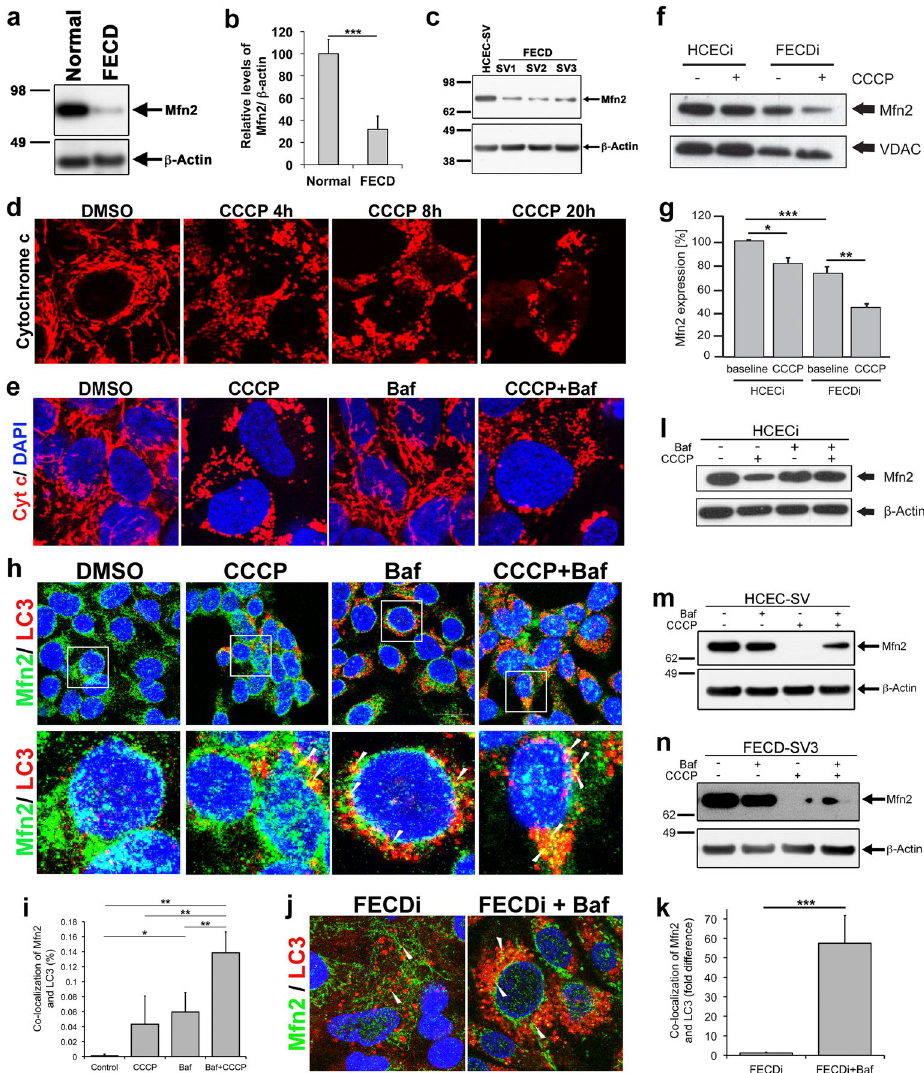
Figure 4. Mitophagy drives loss of mitochondrial fusion protein Mfn2 in FECD. ( a ) Representative western blot of Mfn2 shows reduced expression in an FECD specimen compared to normal donor. ( b ) Quantification of western blot of Mfn2 (average + SEM) normalized with β -actin from normal donors (n = 10) and FECD ex vivo specimens (n = 10) showed a loss of Mfn2 in FECD ( P = 0.0005, Student’s t -test). ( c ) Western blot of SV40 immortalized normal (HCEC-SV) and FECD cell lines (FECD-SV1, -SV2, and -SV3) show reduced Mfn2 levels that corroborated with human specimens. ( d ) Time course of mitochondrial fragmentation observed with the immunolocalization of cytochrome c in normal corneal endothelial cell lines treated with 20 μ M CCCP. ( e ) CCCP- induced mitochondrial fragmentation is unaltered with autophagosome inhibitor bafilomycin (10 nM) (CCCP + baf panel), whereas bafilomycin alone does not disrupt the normal mitochondrial architecture (Baf panel). ( f ) Western blot shows a reduction of Mfn2 in the mitochondrial fractions in normal cell line treated with CCCP as well as basal levels in FECDi cells. ( g ) Quantification of Mfn2 expression levels normalized with VDAC representing average + SEM of three independent experiments. CCCP induces a 42% reduction in Mfn2 in FECDi cells compared to a 20% decrease in HCECi. ( h ) Mfn2 co-localizes with LC3 that visualized moderately in normal cells treated with 20 μ M CCCP for 8 h and increased spots of co-localization are observed with 10 nM bafilomycin (white arrowheads) suggesting degradation of Mfn2 through mitophagy. ( i ) Quantification of co-localization of LC3 and Mfn2 shows an increase in co-localization in bafilomycin treated HCECi cells and a further increase in cells treated with CCCP and bafilomycin. ( j ) FECDi cells show increased autophagosome formation visualized with LC3 staining that appear as vesicles (left panel). Treatment with 10 nM bafilomycin for 16 h led to increase in colocalization of Mfn2 and LC3 (right panel). ( k ) Quantification of co- localization of Mfn2 and LC3 in FECDi cells shows an increase in cells treated with bafilomycin. ( l – n ) Treatment with CCCP and bafilomycin stabilized Mfn2 protein levels as compared to CCCP treatment alone in two normal (HCECi, panel j; HCEC-SV, panel k) and one FECD cell line (FECD-SV3, panel l) suggesting that activated mito/autophagy degradation pathway likely accounts for Mfn2 protein degradation in FECD. Student’s t -test was performed in ( b , k ) and one-way ANOVA in ( i ) to test the statistical significance. * P < 0.05, ** P < 0.01 and *** P <